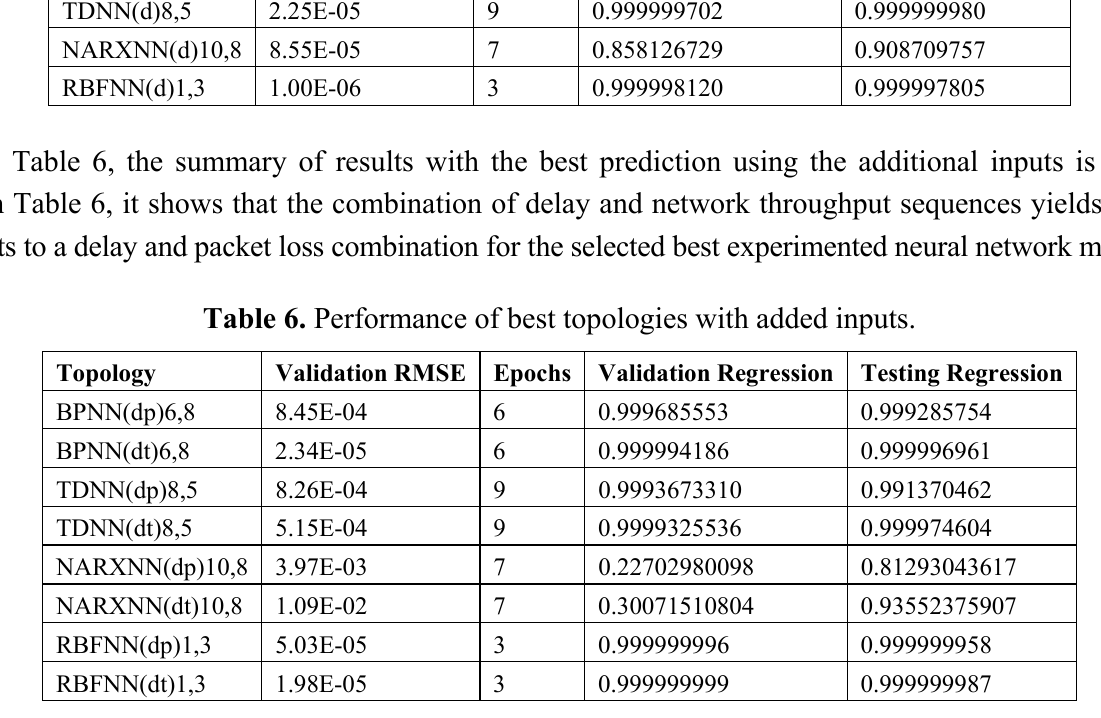
Figure 3. Prediction of delay sequence using BPNN(d)